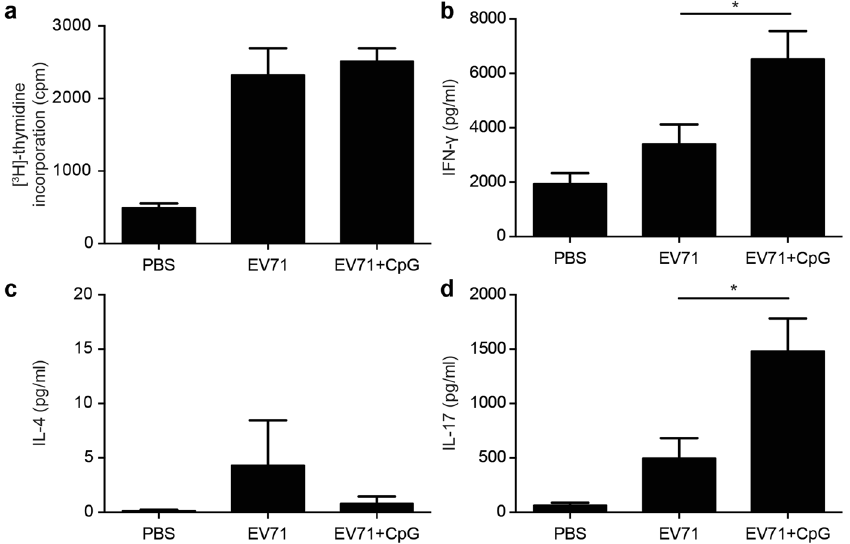
Figure 6. Proliferation and cytokine production of splenocytes derived from immunised mice. Splenocytes from mice immunised with PBS or formalin-inactivated EV71 alone or adjuvanted with CpG were harvested and cultured in medium containing 10 μ g/mL heat-inactivated EV71. ( a ) After 5 days in culture, proliferation was measured as [ 3 H]-thymidine incorporation. Culture supernatants were analysed after 2 days for IFN- γ ( b ), IL-4 ( c ), and IL-17 ( d ) levels in response to heat-inactivated EV71. Thymidine uptake was determined by harvesting cells and using a scintillation counter to measure the level of incorporation (as counts per minute [cpm]). Values shown are means ± SEMs of six mice in each experimental group; * p < 0.05. One representative study of three with similar results is